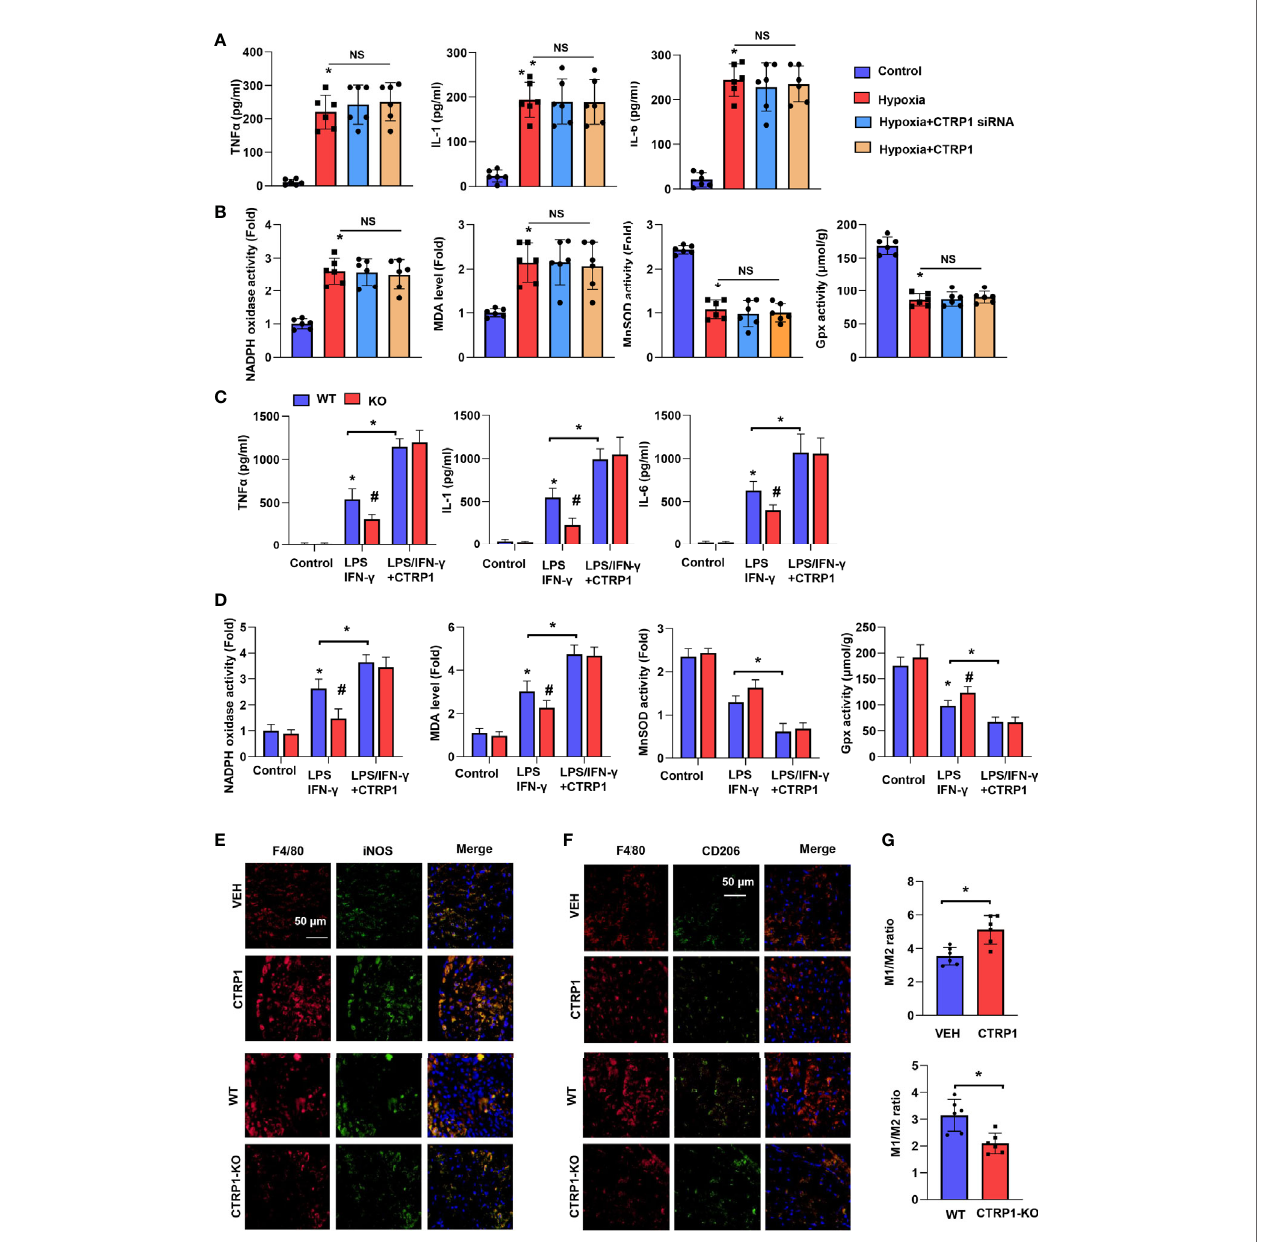
FIGURE 6 | Macrophages account for the effect of CTRP1 on cardiomyocytes. (A) In fl ammatory cytokine levels in NRCMs transfected with CTRP1 siRNA or the human recombinant CTRP1 protein under hypoxia (24 h). (B) Oxidase and anti-oxidase activities and MDA levels in NRCMs in the indicated groups. * P <0.05 vs. the control group. (C) Primary bone marrow-derived macrophages isolated from CTRP-/- mice treated with LPS/IFN- g and the CTRP1 protein for 24 h. In fl ammatory cytokine levels in the indicated groups. (D) NRCMs were cultured with the macrophage supernatants in the indicated groups. Oxidase and anti-oxidase activities and MDA levels in NRCMs. * P <0.05 vs. the WT control group. # P <0.05 vs. the WT-LPS+IFN- g group. All the in vitro experiments were repeated 3 times. NS, not signi fi cant. (E) Representative image of immuno fl uorescence staining for F4/80 and NOS2, or F4/80 and CD206 in CTRP1-KO mice post MI. (F) Representative image of immuno fl uorescence staining for F4/80 and NOS2, or F4/80 and CD206 in CTRP1 injected mice post MI. (G) Quanti fi cation result of F/480 + /NOS2 + to F/ 480 + /CD206 + macrophage ratio in the indicated group (n=6). * P <0.05 vs. the WT/VEH